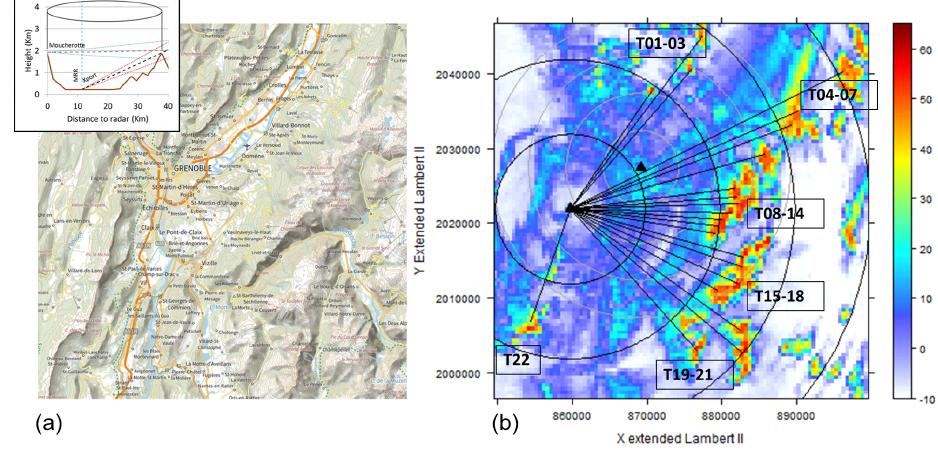
Figure 1. (a) The 50 × 50km 2 map of the region of Grenoble, France (from Geoportail, Institut Géographique National). (b) Dry weather reflectivity map of the X-band weather radar located on top of the Moucherotte mountain (1901ma.s.l.) in the Vercors Massif. The radar is marked with a black triangle, and circular range markers are spaced by 10km. The Cartesian map has a resolution of 500m. The mea- surements were taken at an elevation angle of 0 ◦ during dry weather conditions before the 21 July 2017 event. The radial lines indicate the azimuths and ranges of the 22 mountain targets used for the MRT implementation. Targets 1–3 are located in the Chartreuse Massif, targets 4–14 in the Belledonne Massif, targets 15–21 in the Taillefer Massif and target 22 in the Vercors Massif. In the background, the second black triangle indicates the IGE site at the bottom of the valley (210ma.s.l.). The grey circles with 5km spacing indicate the coverage of the XPORT X-band polarimetric radar, whose measurements were used in the present study only for the detection of the melting